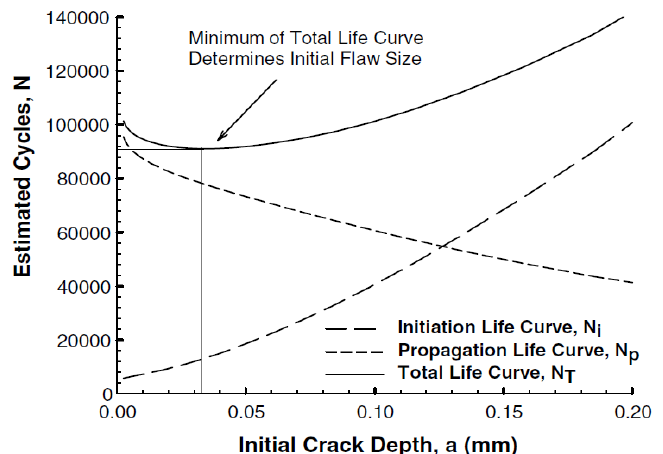
Figure 4. Variable initiation crack length (mm) versus number of cycles [20].